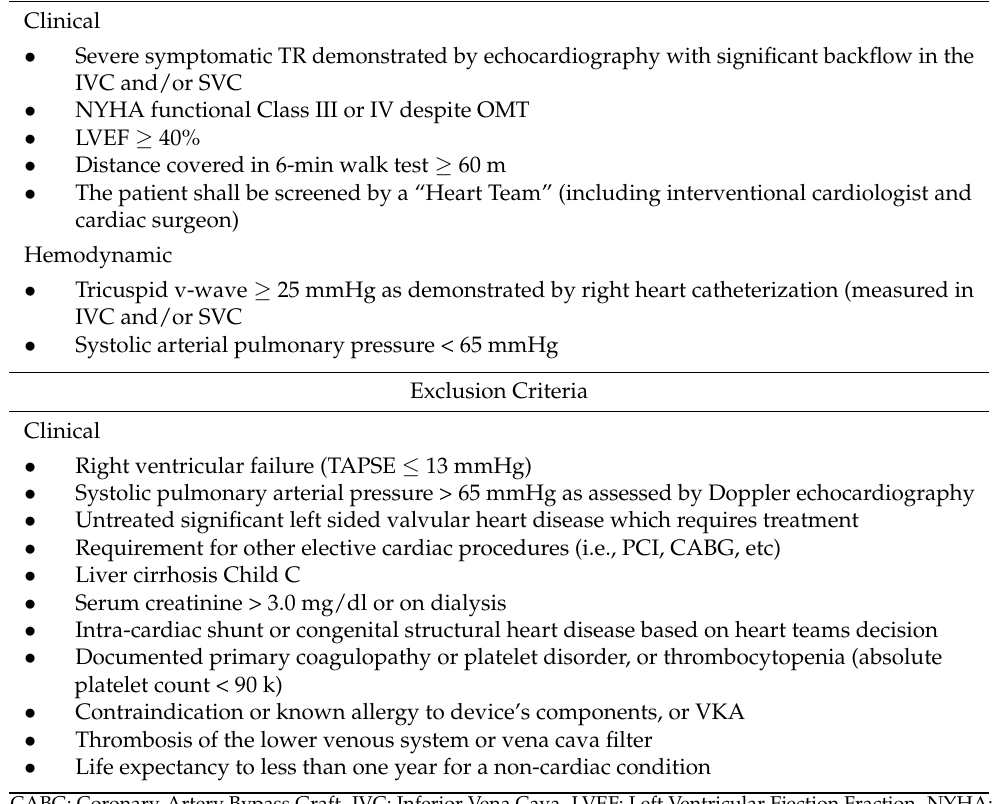
Table 3. Main clinical and hemodynamic eligibility criteria for the TRICUS Study and TRICUS EURO. Inclusion